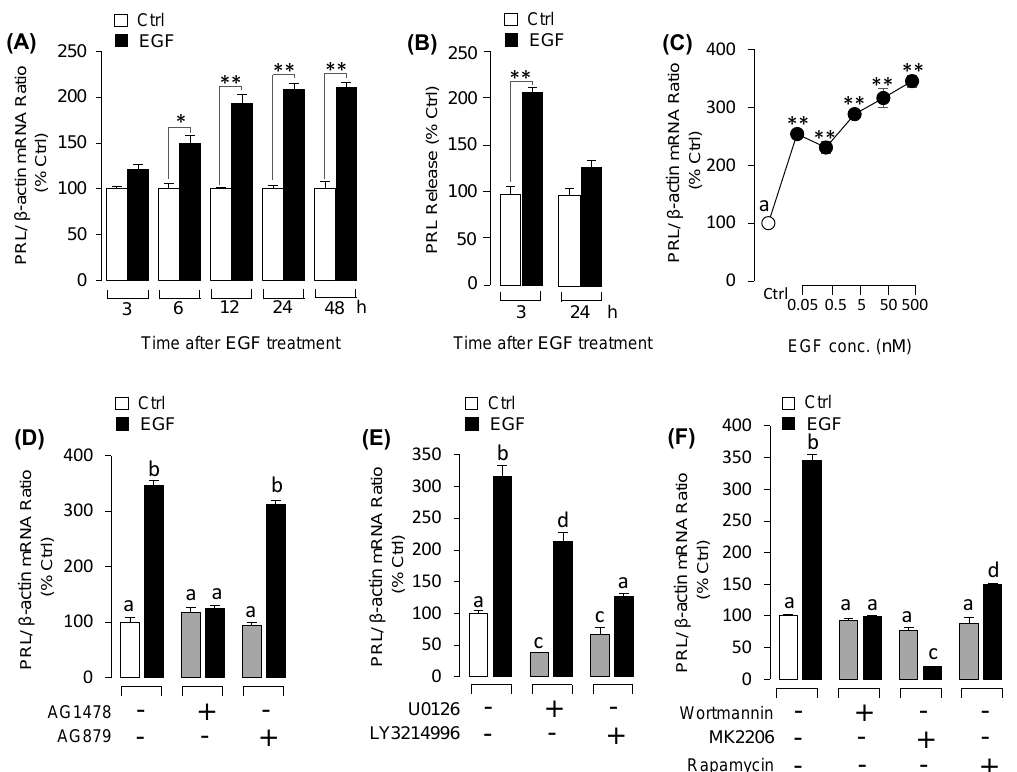
Figure 6. EGF induced prolactin (PRL) mRNA expression in grass carp pituitary cells: Receptor specificity and signal pathways. ( A ) Time course of EGF (50 nM) on PRL mRNA expression. ( B ) Time course of EGF (50 nM) on PRL release in grass carp pituitary cells. ( C ) Dose-dependence of 48-h treatment with increasing levels of EGF (0.05–500 nM) on PRL mRNA expression. ( D ) Receptor specificity for PRL regulation by EGF. In this experiment, grass carp pituitary cells were treated for 48-h with EGF (50 nM) in the presence or absence of ErbB1 inhibitor AG1478 (5 µ M) or ErbB2 inhibitor AG879 (5 µ M). ( E ) The e ff ects of 48-h cotreatment with MEK 1 / 2 inhibitor U0126 (5 µ M) or ERK 1 / 2 inhibitor LY3214996 (5 µ M) on EGF (50 nM)-induced PRL mRNA expression. ( F ) The e ff ects of 48-h cotreatment with PI 3 K inhibitor wortmannin (5 µ M), Akt inhibitor MK2206 (5 µ M) or mTOR inhibitor rapamycin (5 µ M) on EGF (50 nM)-induced PRL mRNA expression. After drug treatment, the total RNA was collected and prepared for real-time PCR of PRL mRNA expression. Data presented are expressed as mean ± SEM ( n = 4). p < 0.05 (“*”) and p < 0.01 (“**”) were used to present significant di ff erences among each group. And the di ff erent letters represent a significant di ff erence at p < 0.05 between groups (ANOVA followed by a Dunnett